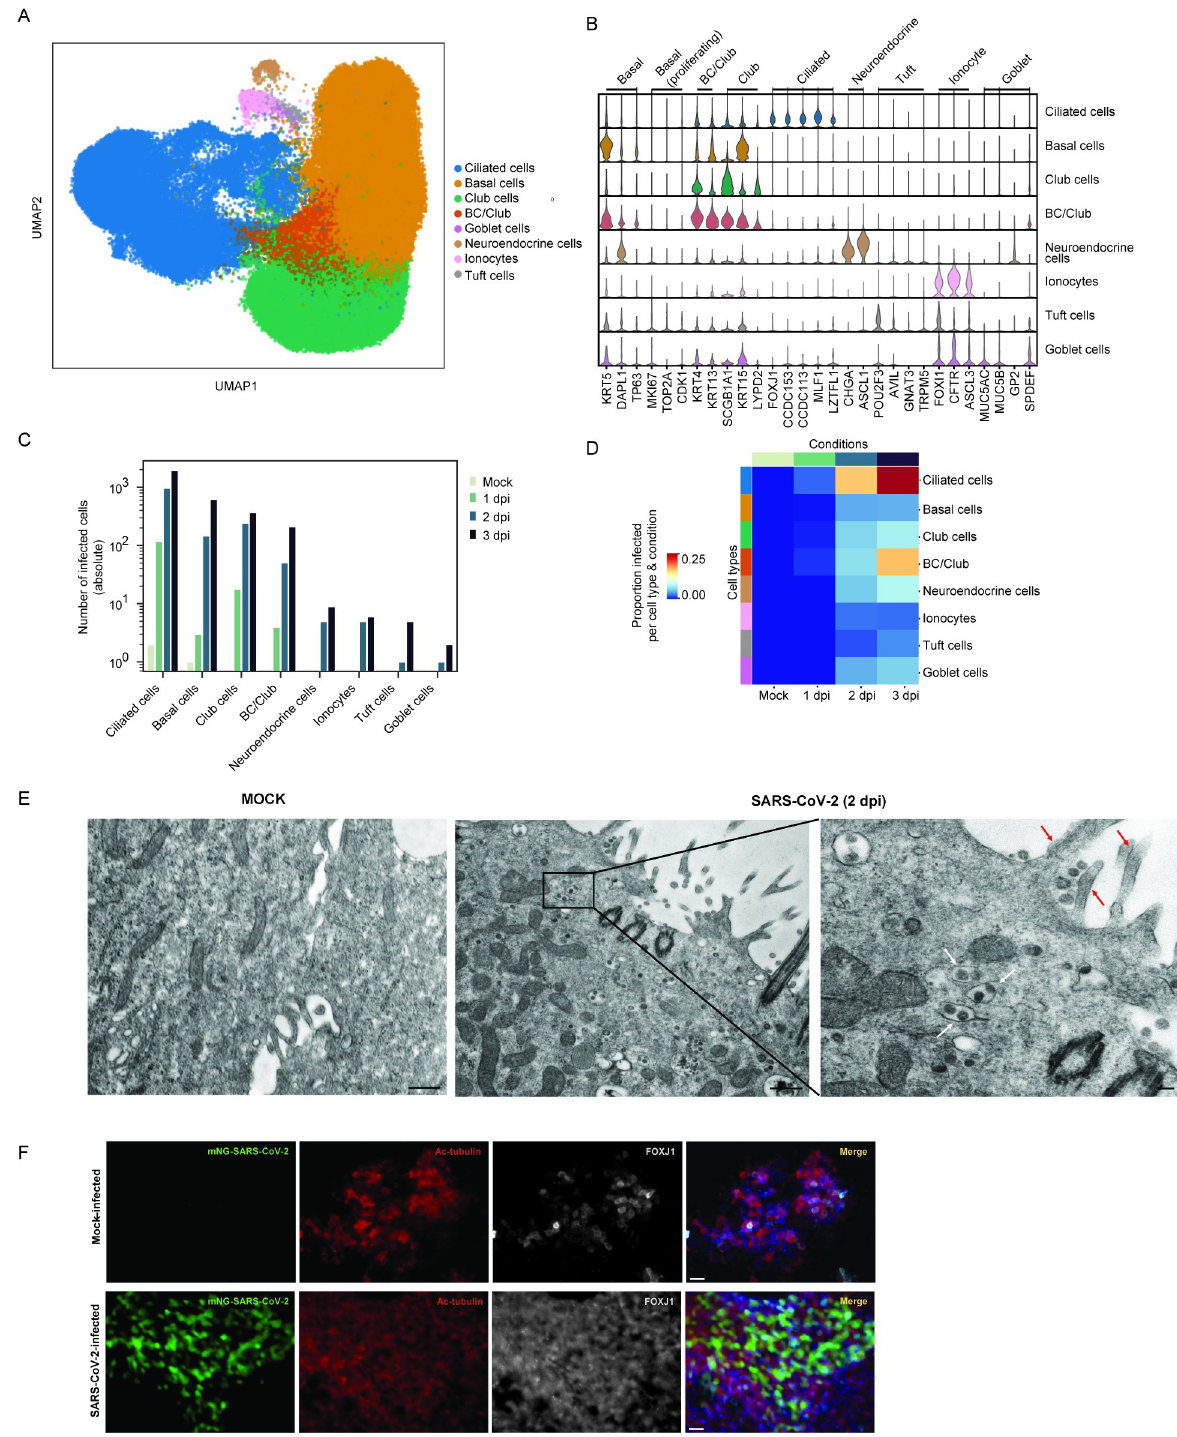
Fig 3. SARS-CoV-2 tropism in primary HBECs reveals ciliated cells as primary target cells. (A) UMAP visualization of the cell clusters after manual annotation. The UMAP projections of the dataset are color coded by cell type. Eight distinct cell clusters were identified: ciliated, basal, club, a mixture of basal and club cells (BC/Club), goblet, neuroendocrine, ionocytes, and tuft cells. (B) Louvain clusters were annotated with a cell type based on enrichment of canonical cell type markers (see Materials and methods). Violin plots show range-scaled expression (normalized and square-root transformed counts) of marker genes across clusters. (C) Reads mapping to the full SARS-CoV-2 genome were mapped to each of the 8 distinct cell types; cells with greater than or equal to 10 viral transcript counts were considered infected. The absolute number of infected cells in